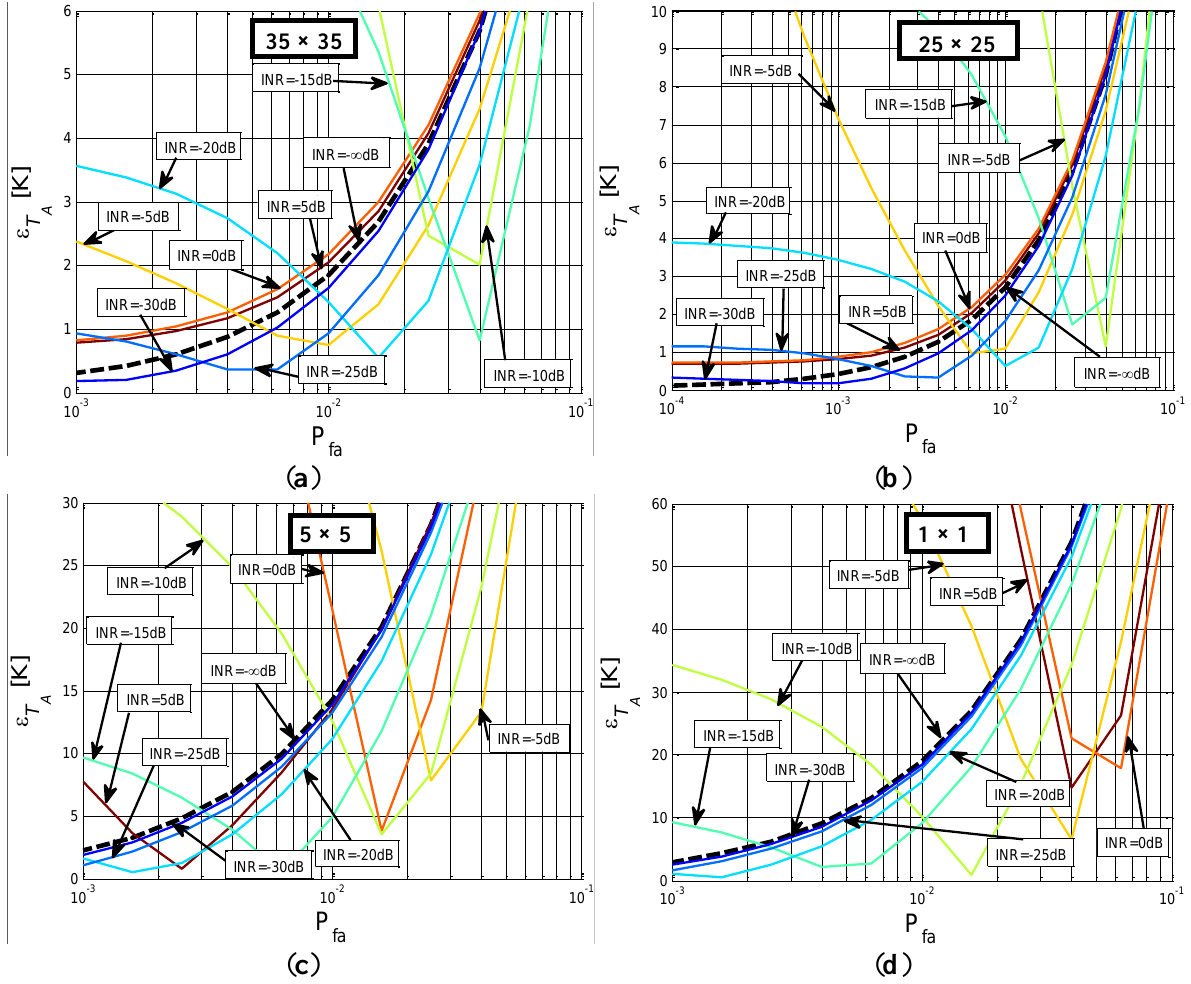
Figure 13. Error obtained by the Smoothing Algorithm in the retrieved T broadband OFDM signal, using a Hann window as smoothing filter. ( a ) 35 × 35 Hann window; ( b ) 25 × 25 Hann window; ( c ) 5 × 5 Hann window; ( d ) without using the Smoothing